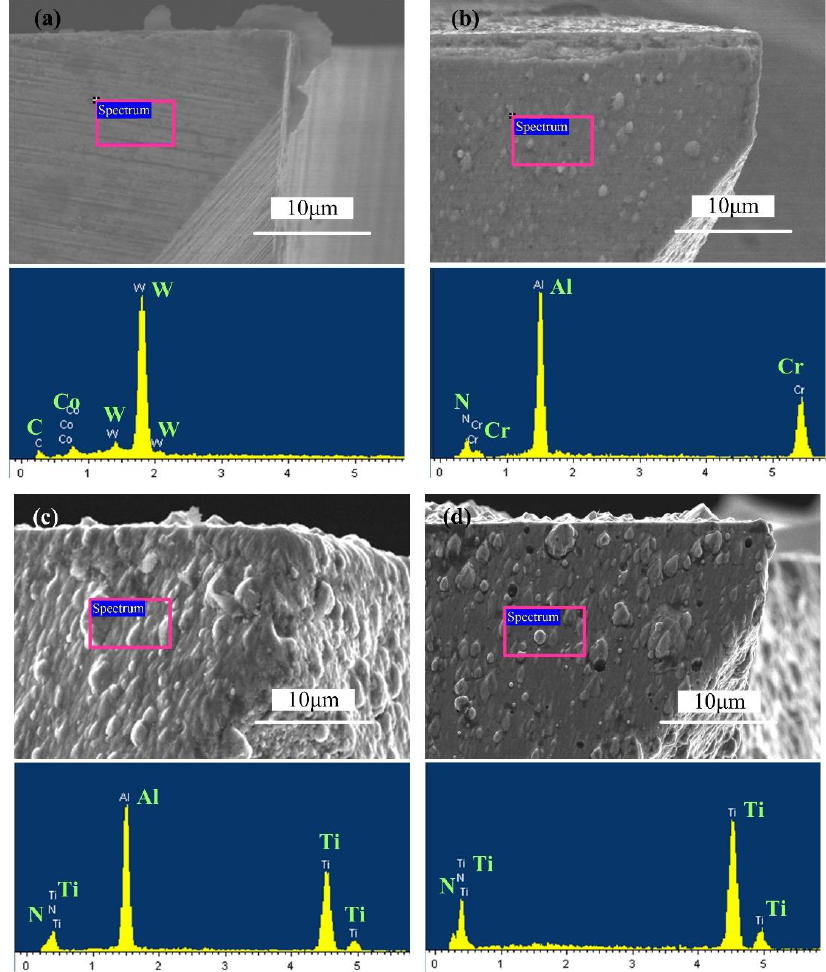
Figure 2. Surface morphologies and energy-dispersive spectroscopy (EDS) of differently coated micro end mill flank faces. ( a ) Uncoated micro end mill; ( b ) AlCrN-based coated micro end mill; ( c ) AlTiN-based coated micro end mill; ( d ) TiN coated micro end mill.